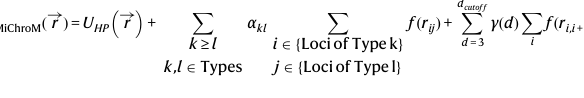
Fig. 4 | Effectsofchanging the centromere-telomeres separation distance. Left panels show the results applying more and less tension in the mosquito genome. Right panels present the analysis of simulations using the Human genome para- meters (MiChroM 8 ). Representative 3D structures of each condition are shown